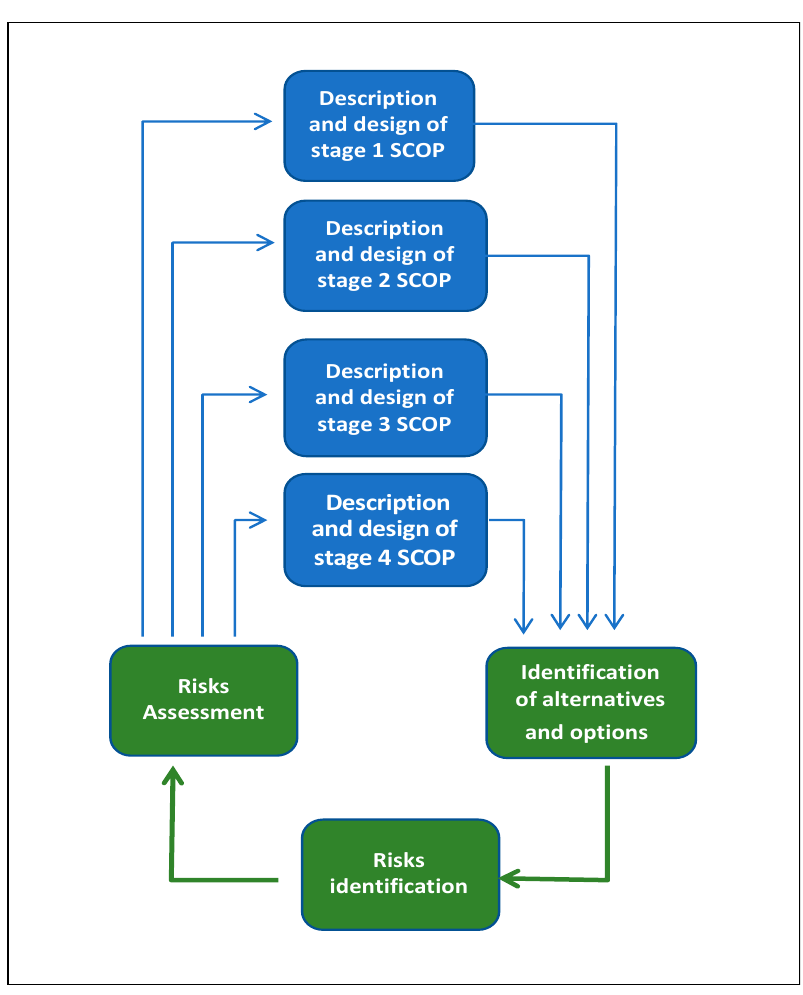
Figure 2. Procedure for the consideration of risk in the design of the Supply chains (SC).